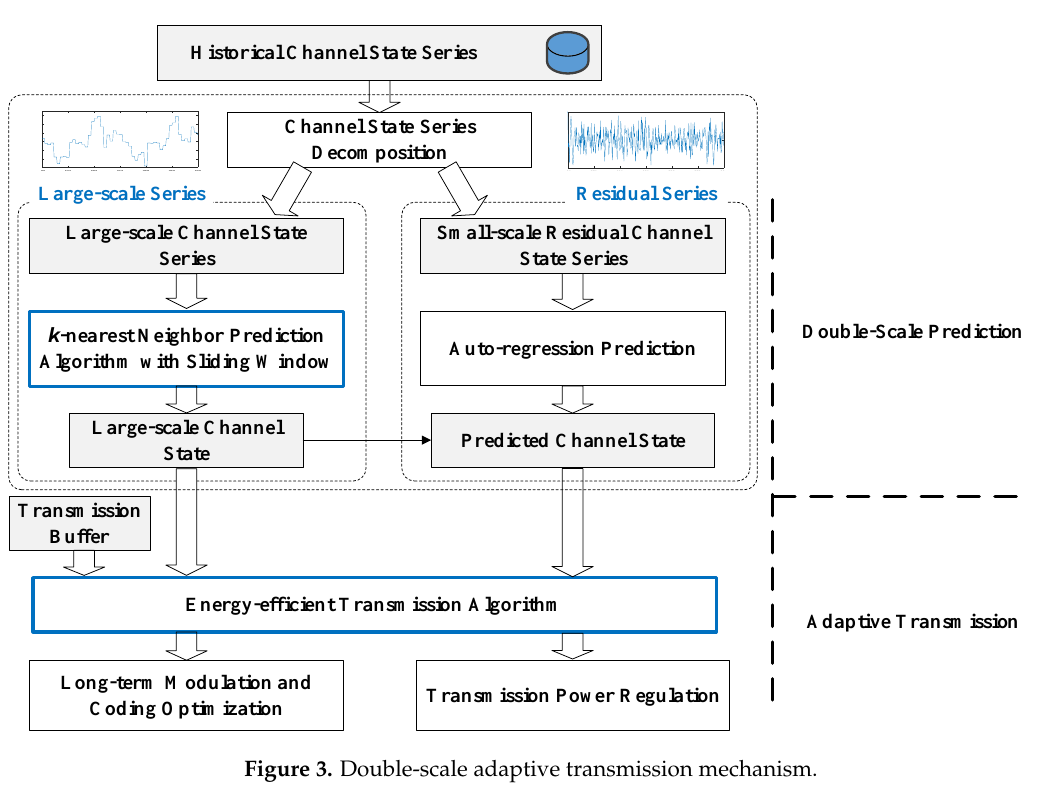
Figure 3. Double-scale adaptive transmission mechanism.